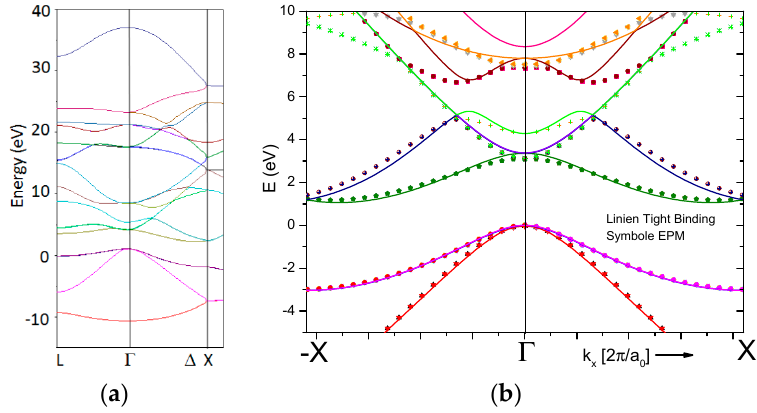
Figure 14. Band structure of silicon calculated by tight binding method ( a ) and part of the band structure in <100>-directions ( b ) calculated using the tight binding (lines) and empirical pseudopotential methods (symbols), respectively.